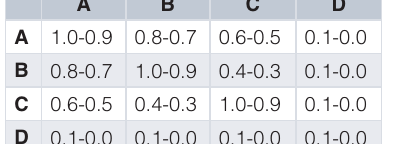
Figure 1. Kamada-Kawai network of a model data set. Shown is the KK CSN of the model data set according to Table 2. Data points are colored on the basis of compound subset membership: A, blue; B, red; C, green; D,